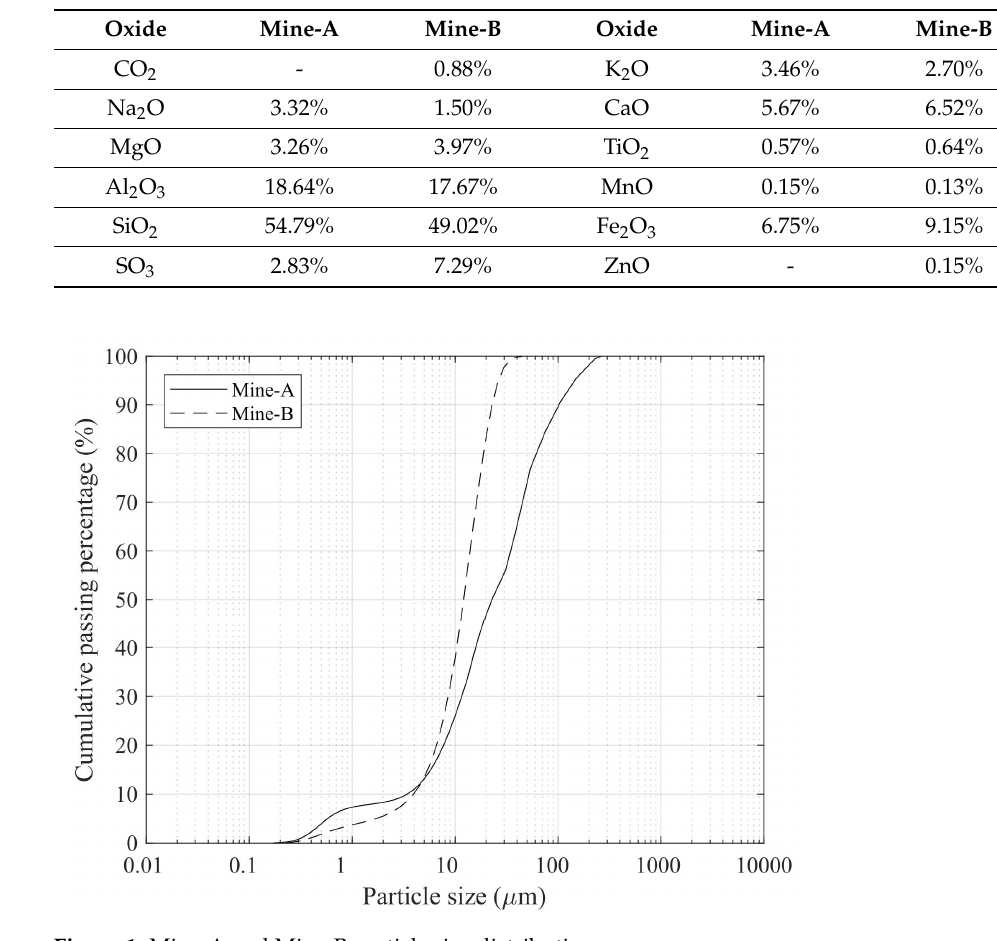
Table 1. Mine-A and Mine-B tailings composition.